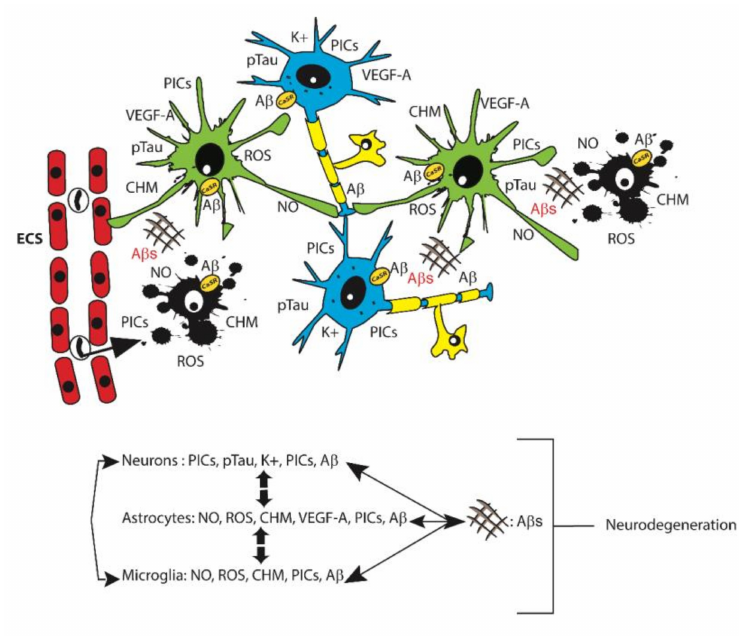
Figure 1. Top : A summary representation of the main cell types and proinflammatory factors each of them releases into the extracellular matrix in the course of AD. Neurons, blue. Astrocytes, green. Oligodendrocytes, yellow. Microglia, black. Endothelial cells (ECs), red. Monocytes, colorless. A black arrow indicates the migration of a monocyte into the nervous tissue. Senile plaques, ## A β s. Most of the abbreviations as in the text. CHM, chemokines. PICs, proinflammatory cytokines. CaSR, calcium-sensing receptor. Bottom : Schematic diagram of the reciprocal interactions between the three main neural cell types involved in Alzheimer-related neuroinflammation. The bidirectional interaction with amyloid senile plaques is also